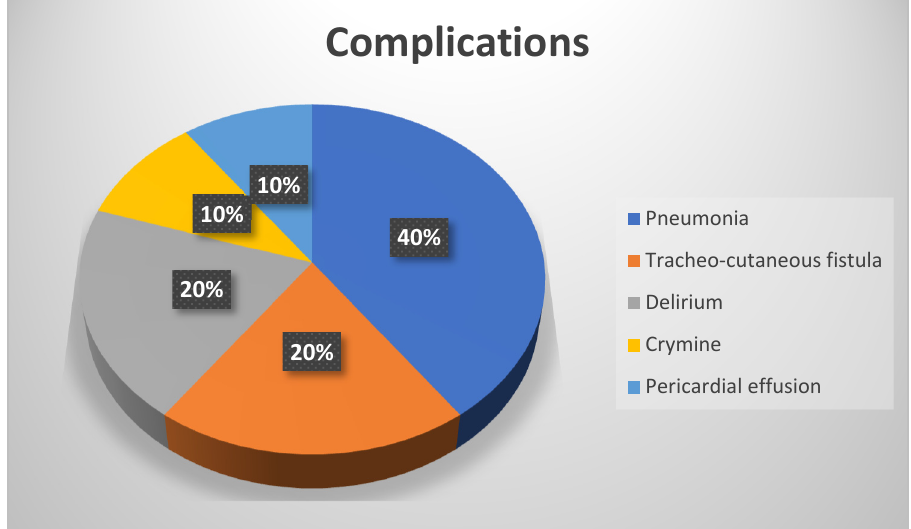
Figure 3. Postoperative complications.